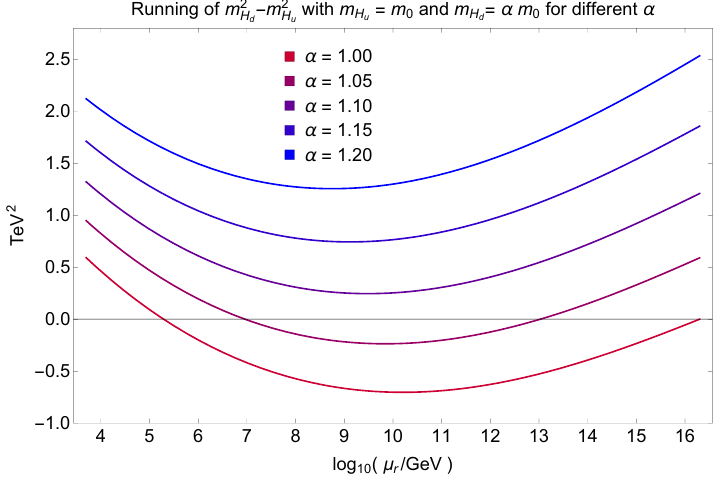
Figure 8 . The RGE running of m 2 and m 2 at the GUT scale, where m H H u example point (3.11){(3.20). We see that RGE running to the SUSY scale preserves the initial split in the mass